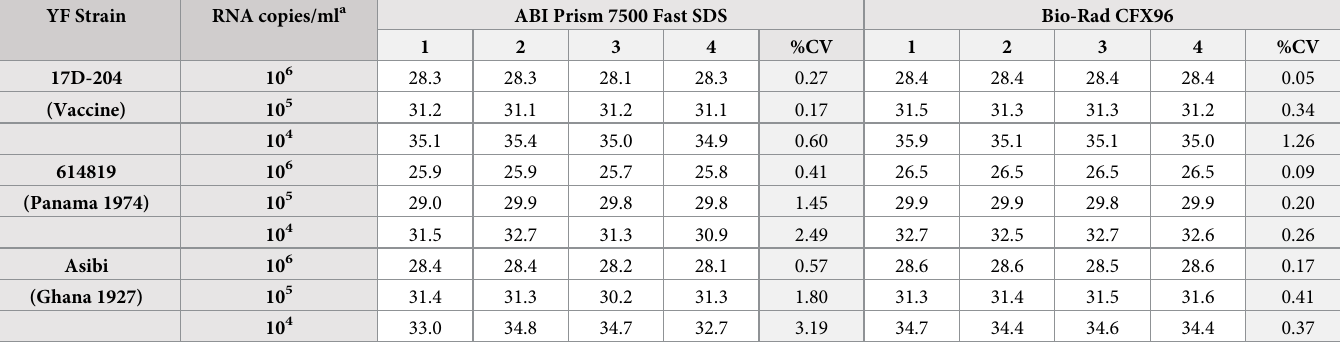
Table 6. Comparison of precision values for the RealStar Yellow Fever Virus RT-PCR kit 1.0 using ABI Prism 7500 Fast SDS and Bio-Rad CFX96. YF Strain